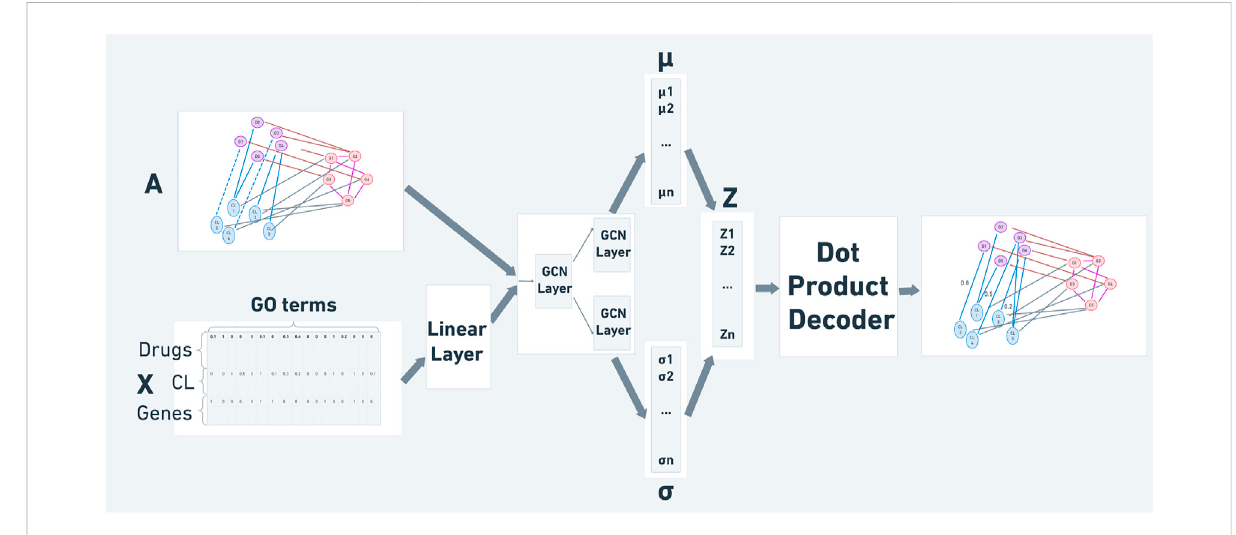
FIGURE 1 An illustration of our fi nalconstructed model for drug sensitivity prediction. The adjacency matrix A with themasked sensitivityinteractionsand feature matrix X serve as inputs. The fi nal output is the reconstructed ~ A adjacency matrix, allowing the prediction of new drug-cell line